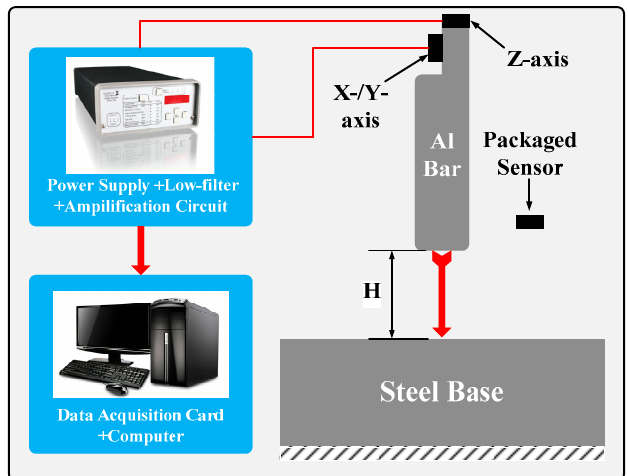
Figure 6. Schematic of the dropping hammer testing system.